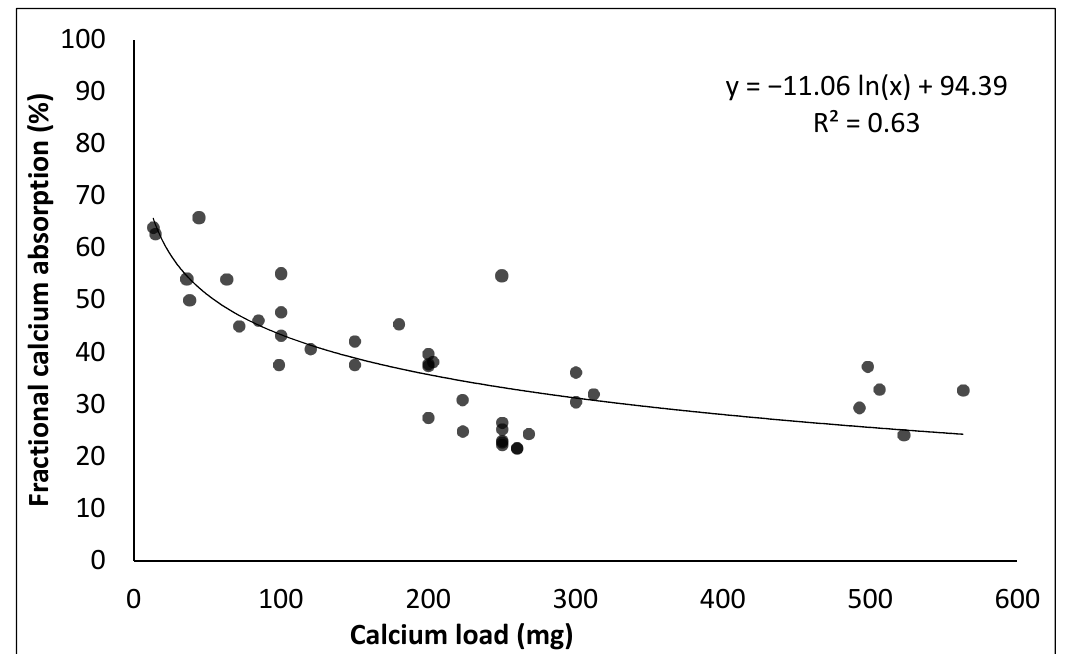
Figure 1. Influence of calcium load on fractional absorption of calcium from dairy products. Data from Table 4.